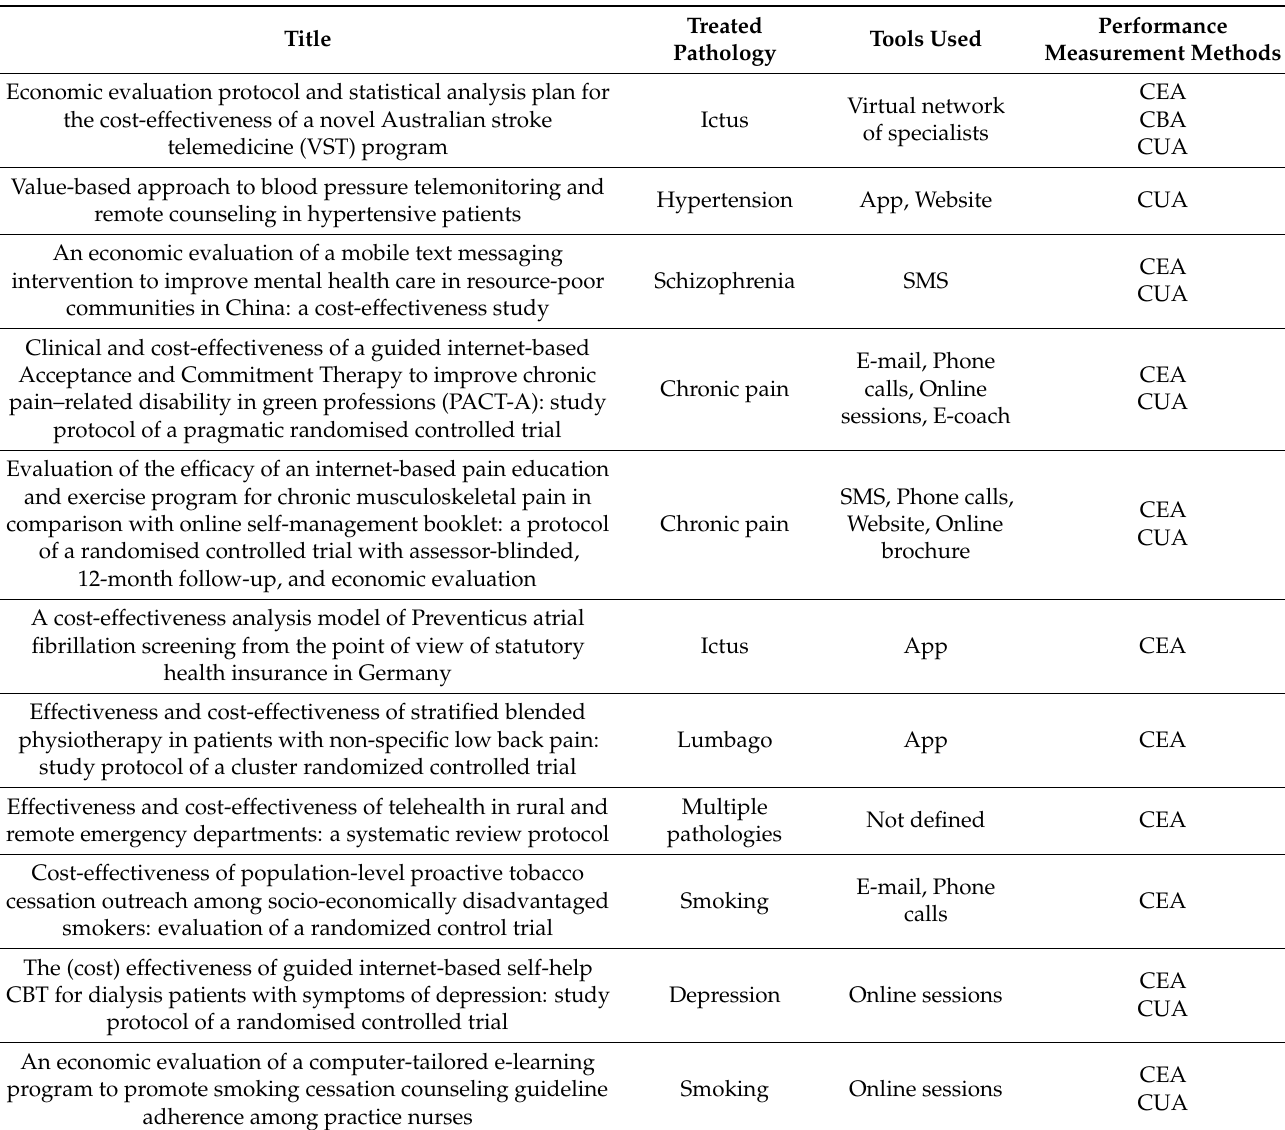
Table 3. Performance measurement methods, treated pathology, and tools used for each contribution analyzed (excluding literature reviews).